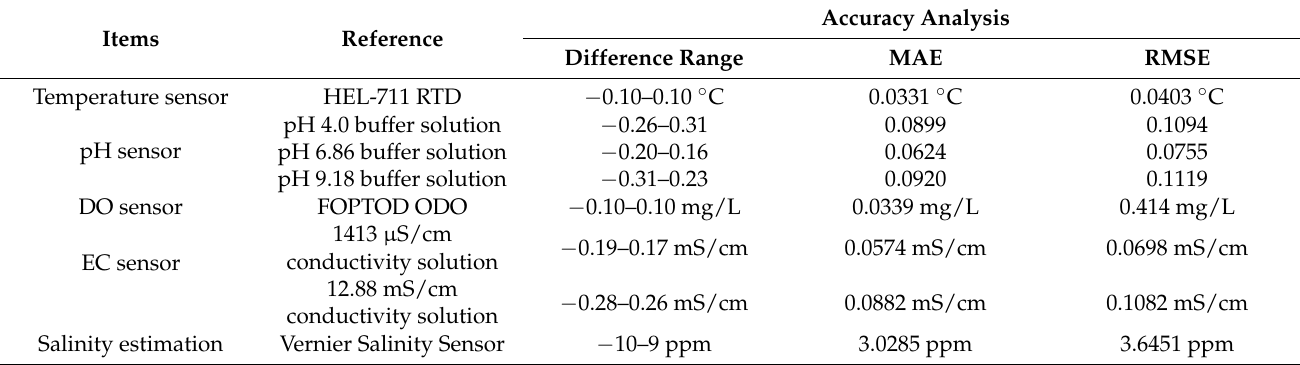
Table 5. Accuracy analysis of water temperature, pH, DO, and EC, and salinity levels for pre-calibration.